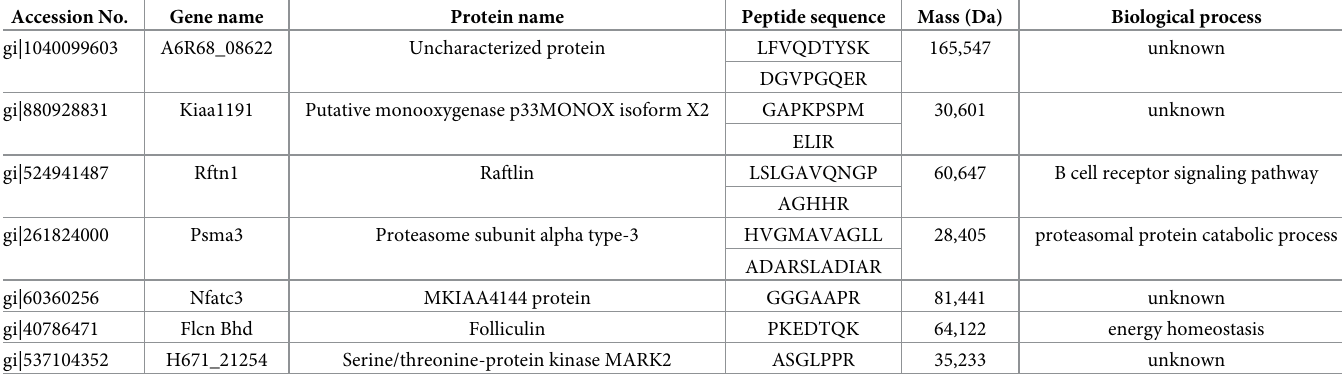
Table 2. Protein identification and functional classification of unique proteins in diabetic mice treated with cordycepin (DM+COR). Accession